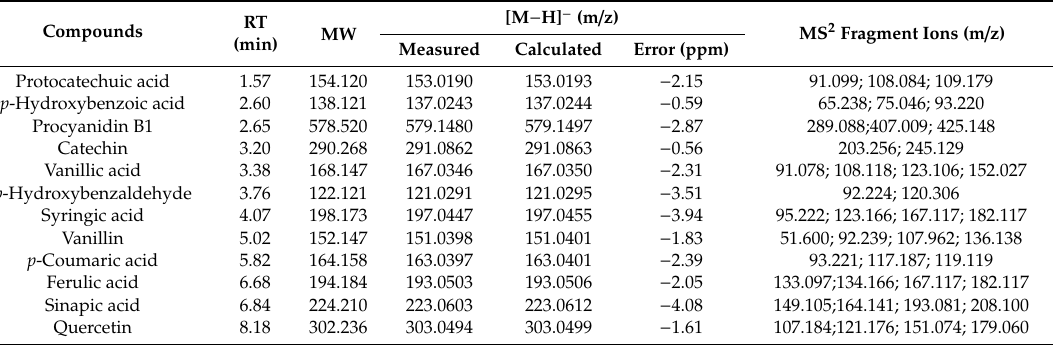
Table 5. Retention times, MW, and MS and MS 2 fragmentation ions of 9 phenolic and 3 flavonoid compounds